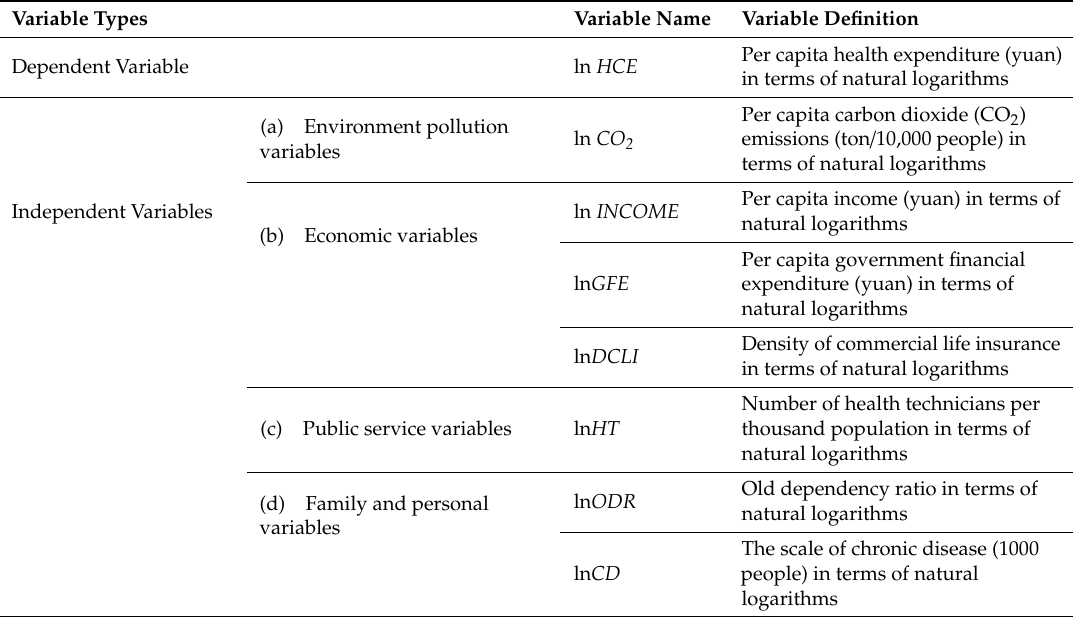
Table 2. Variable selection and definition.